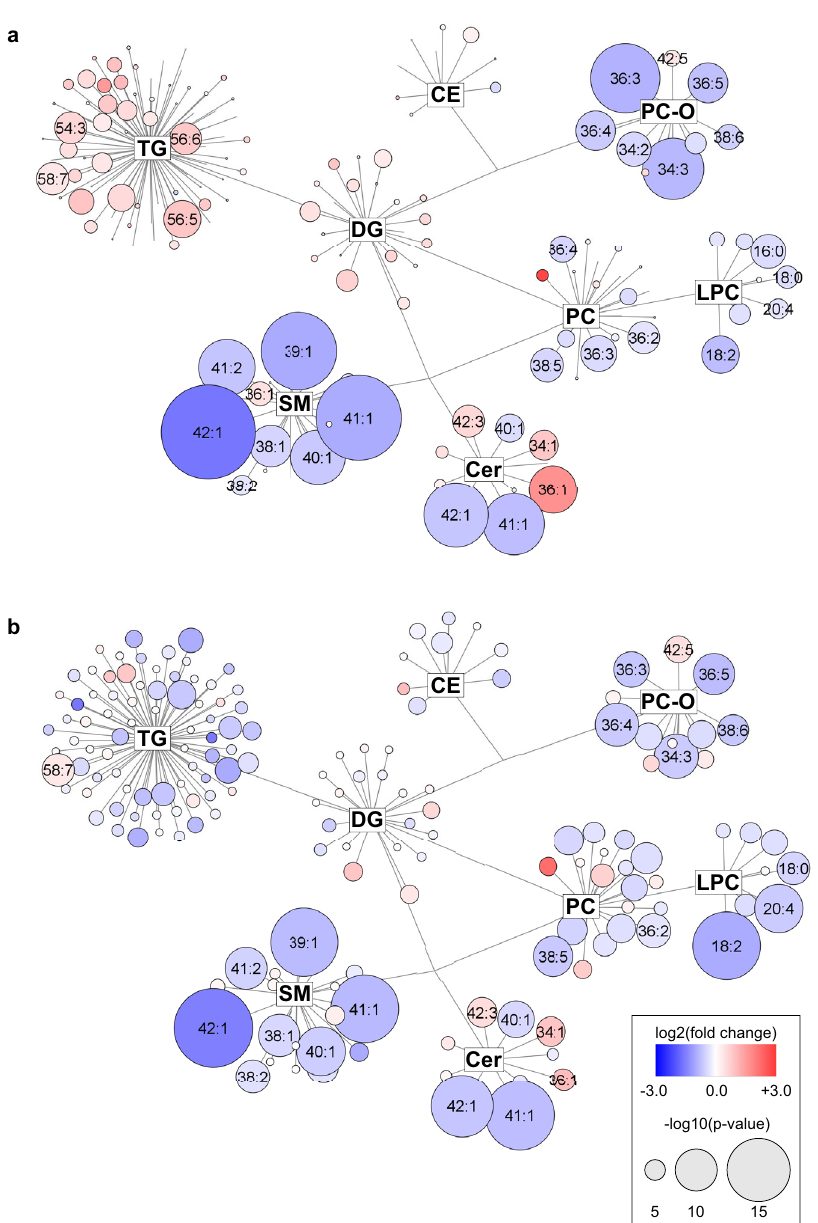
Fig. 10 Network visualization of the most dysregulated lipid species in PDAC for data from Phase III. Graphs show lipidomic pathways with clustering into individual lipid classes for a males, and b females using the Cytoscape software (http://www.cytoscape.org). Circles represent the detected lipid species, where the circle size expresses the signi fi cance according to p -value, while the color darkness de fi nes the degree of up/downregulation (red/blue) according to the fold change. The most discriminating lipids are annotated. Source data are provided as a Source Data fi